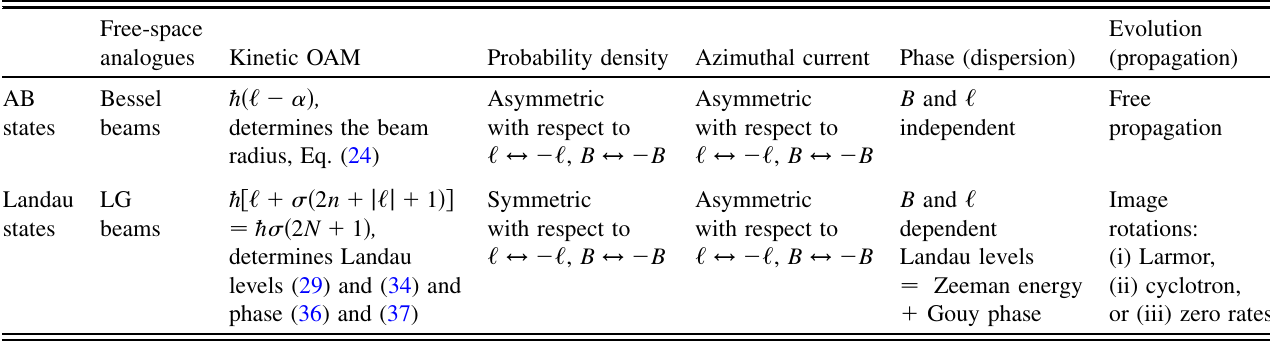
TABLE I. Summary of the main features of the OAM–magnetic-field coupling revealed in the Aharonov-Bohm (AB) and Landau stationary propagating modes. These modes represent the Bessel and LG beams in the presence of a magnetic-flux line and uniform magnetic field,